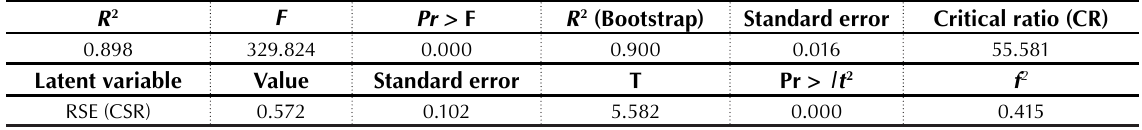
Table 12. Effect of improving CSR practices on the attraction of